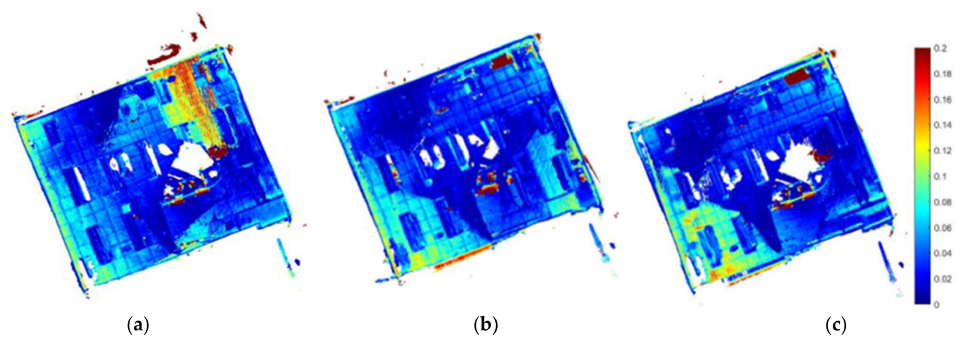
Figure 7. Moderate-texture PTPD (m) between exploration models and the ground truth model.